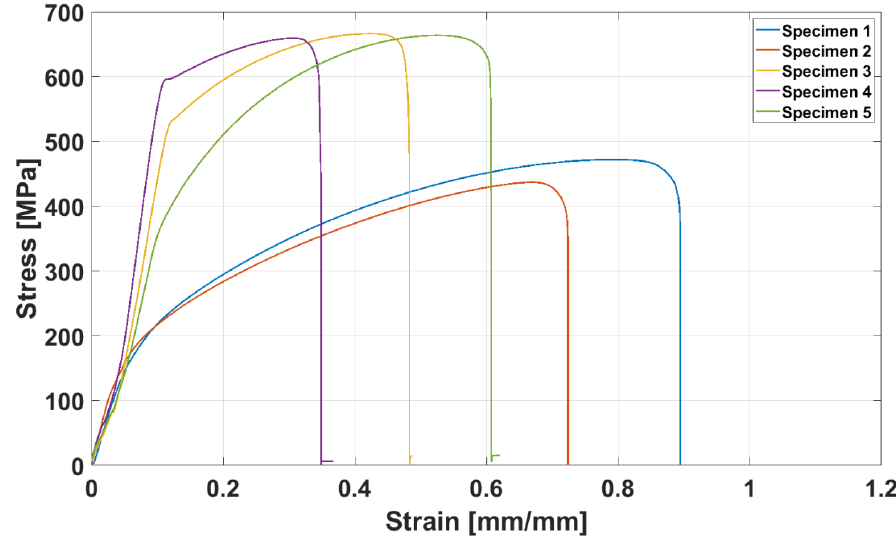
Figure 8 . Tensile stress – strain curves .